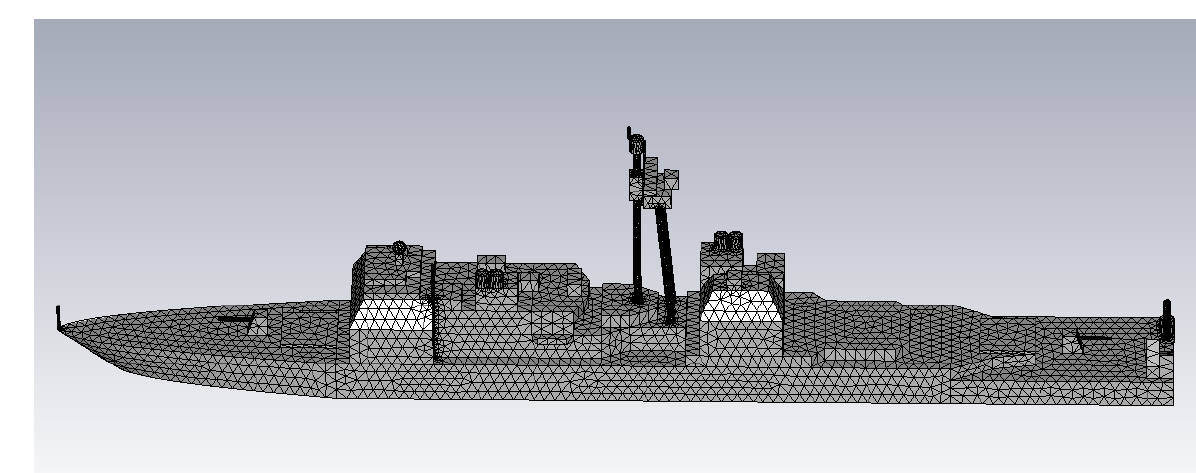
Figure 2. Hexahedron meshing model of a ship.